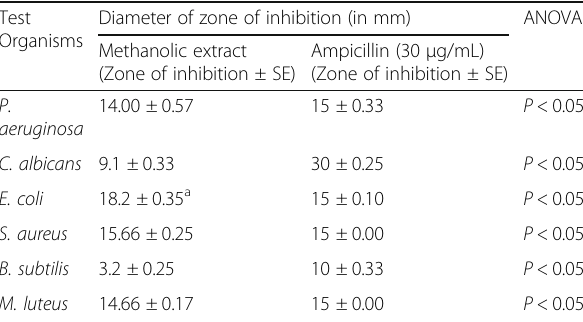
Table 2 Antimicrobial activity of methanolic extract of Bidens pilosa leaves using agar well diffusion method Test Diameter of zone of inhibition (in mm) Organisms